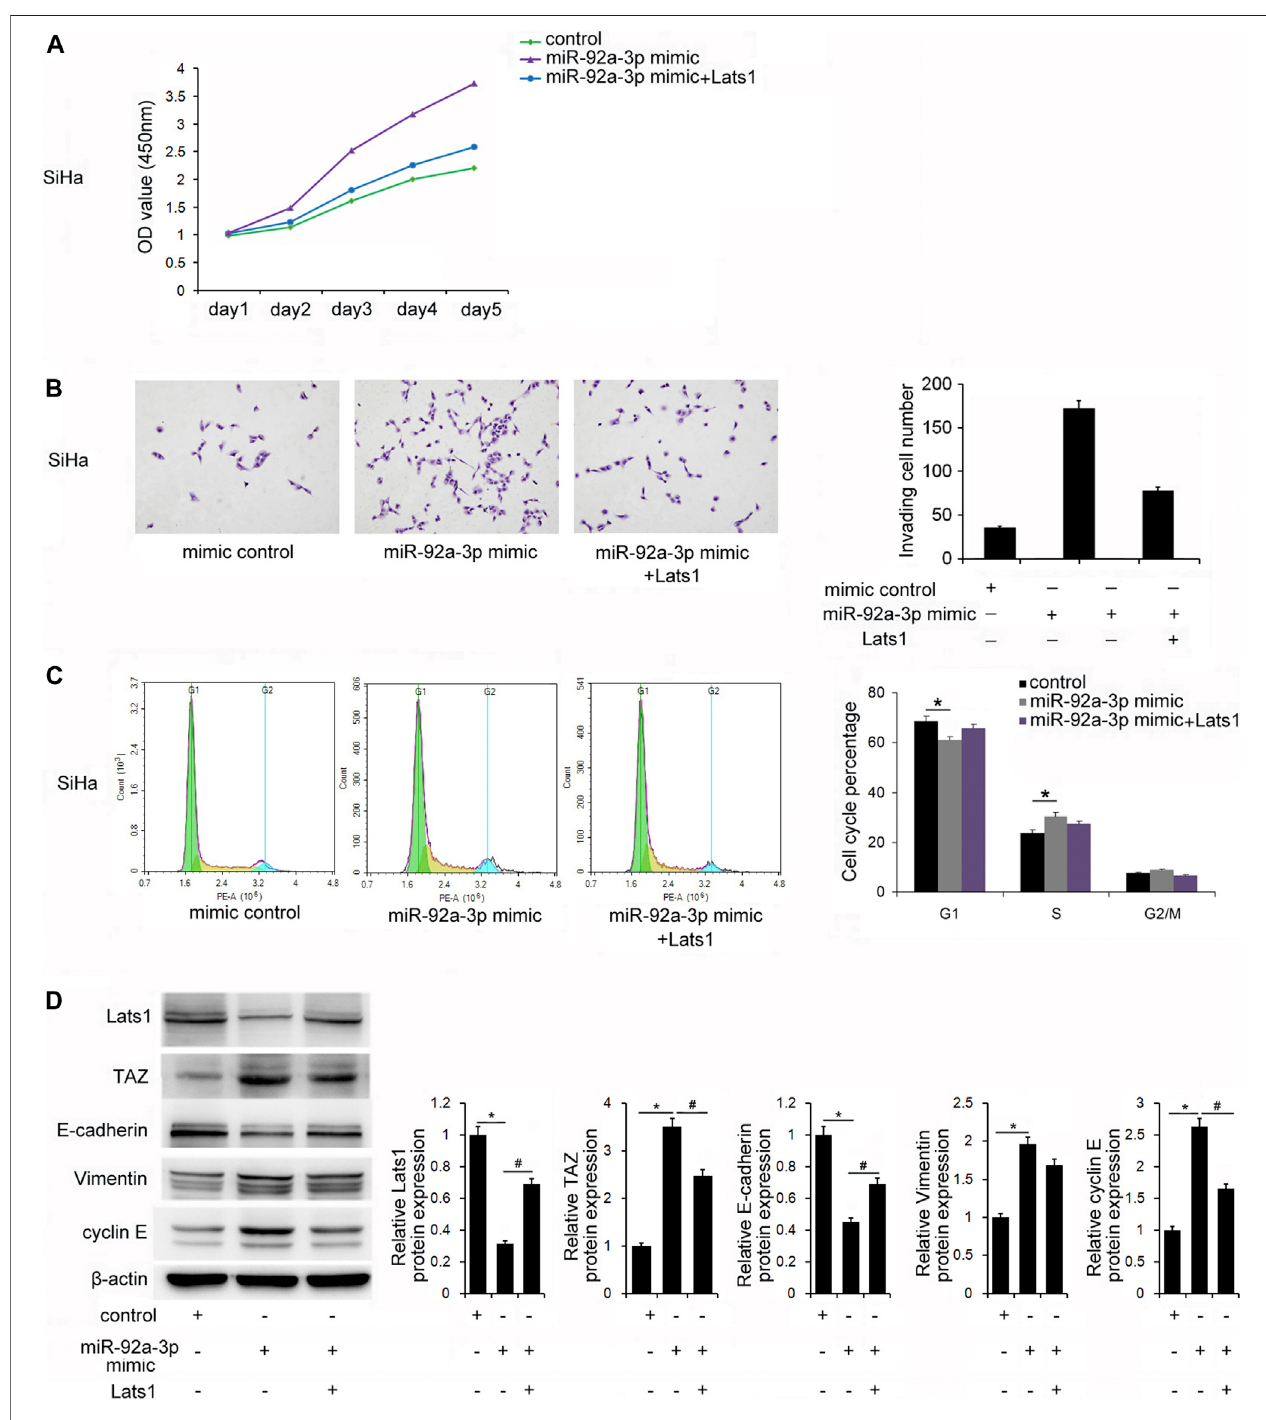
FIGURE 5 | miR-92a-3p regulated biological behaviors via targeting large tumor suppressor 1 (LATS1) in cervical cancer stem cells. (A) The Cell Counting Kit-8 assay showed that the miR-92a-3p mimic increased cell growth, and restoration of LATS1 in cells with miR-92a-3p overexpression suppresssed growth. (B) The Transwell invasion assay results showed that the number of invading cells was increased after transfection of the miR-92a-3p mimic. LATS1 restoration abolished the positive effect of miR-92a-3p on invasion. (C) Flow cytometry results showed that miR-92a-3p overexpression signi fi cantly decreased the G1 percentage and increased the S percentage of cells. LATS1 transfection reversed the effect of miR-92a-3p on the G1-S cell cycle progression. (D) Western blotting results showed that miR-92a-3poverexpressiondownregulated LATS1,E-cadherin,and upregulatedTAZ,vimentin,andcyclinE.LATS1restorationdownregulatedTAZ, Vimentin,cyclinE and upregulated E-cadherin. * p < 0.05 miR-92a-3p mimic vs. the control; # p < 0.05 miR-92a-3p mimic + Lats1 vs. the miR-92a-3p mimic.